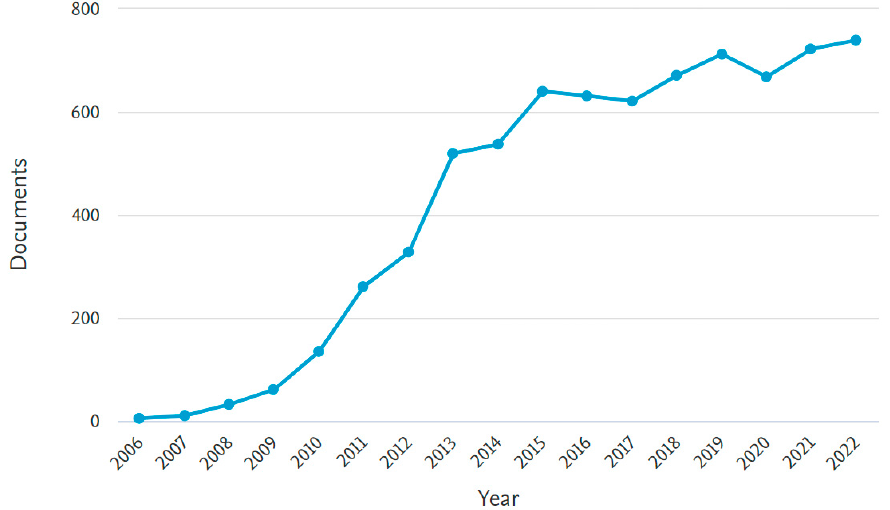
Figure 3. The number of published papers discussing the production of biofuels from microalgae from 2006 to 2022.